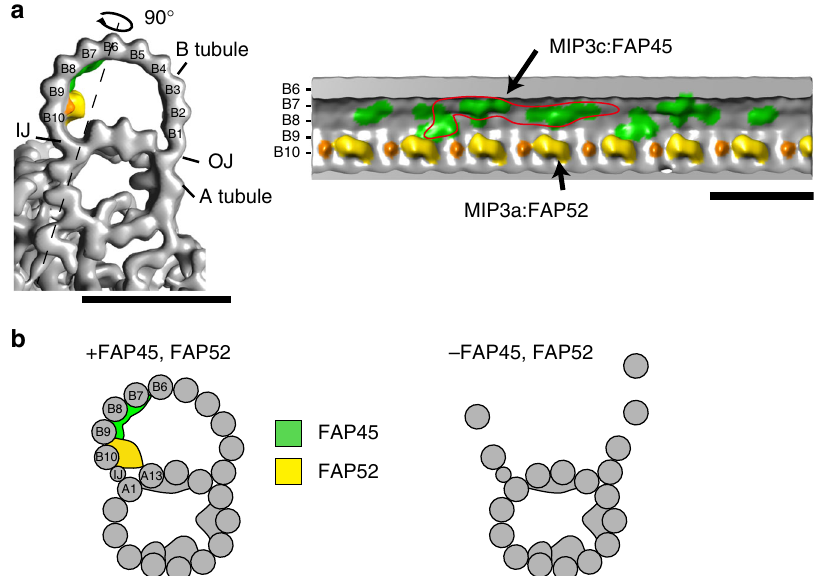
Fig. 7 A schematic model of MIP3. a Isosurface rendering of the wild type density map. MIP3a-c is highlighted as shown in Fig. 2 (MIP3a: yellow; MIP3b: orange; MIP3c: green). The right map is the longitudinal view sliced by the line in the left map. A possible unit of MIP3c is circled in red. Scale bar = 25 nm. b A model of DMT stabilization. FAP45 (green) and FAP52 (yellow) are localized on the inner lumen of the B-tubule and stabilize the MT wall. In particular, FAP45 ties proto fi laments B7 – B9. FAP52 anchors B9 and B10 to A13 and binds to FAP45. Thus, these proteins strengthen the MT wall against